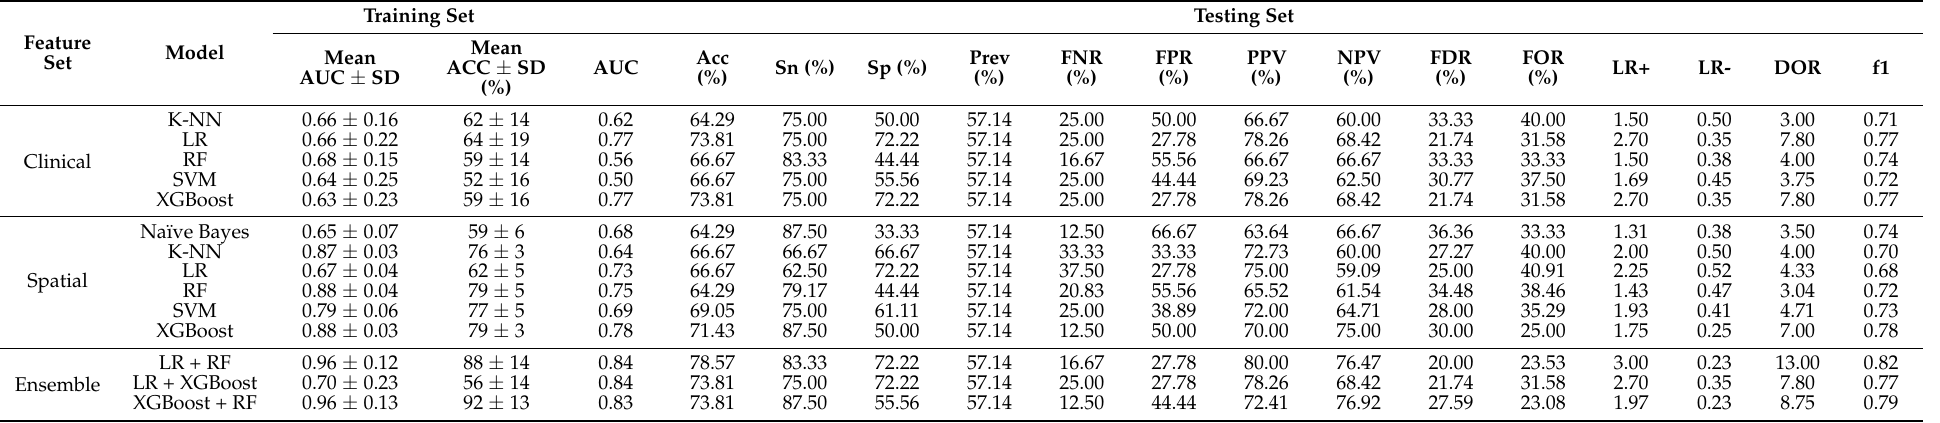
Table 3. Performance measures of machine learning models, trained using clinical and spatial features sets. All models were trained using 10-fold cross-validation and tested on an independent hold-out set. The three highest performing ensemble models are reported. All performance measures are reported at the patient level. Abbreviations: K-NN, K-nearest neighbor; LR, logistic regression; RF, random forest classifier; SVM, support vector machine; XGBoost, extreme gradient boost; AUC, area under the curve; SD, standard deviation; ACC, accuracy; Sn, sensitivity; Sp, specificity; Prev, prevalence; FNR, false-negative rate; FPV, false-positive rate; PPV, positive predictive value; NPV, negative predictive value; FDR, false discovery rate; FOR, false omission rate; LR+, positive likelihood ratio; LR-, negative likelihood ratio; DOR, diagnostic odds